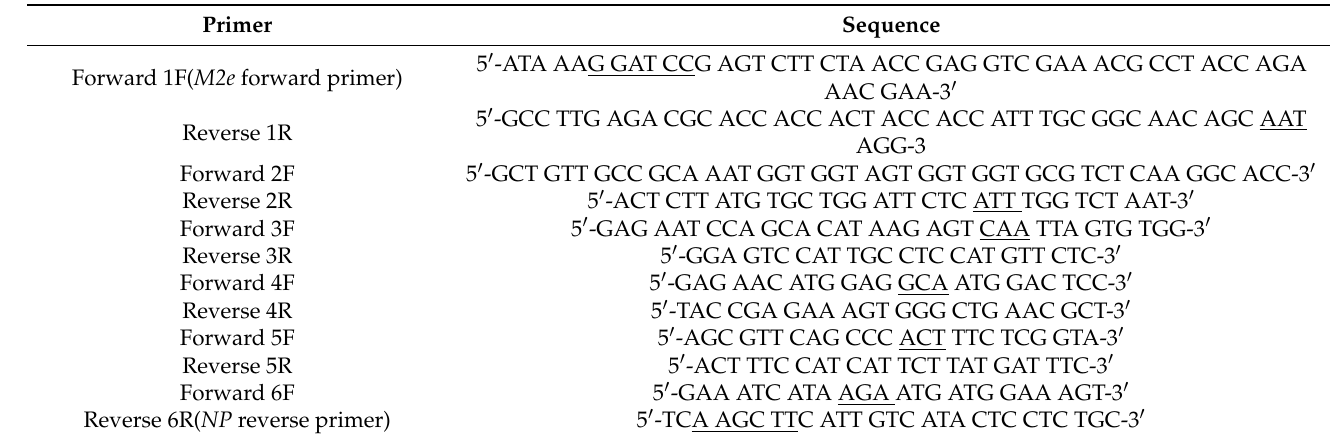
Table 2. Primers used in PCR site-directed